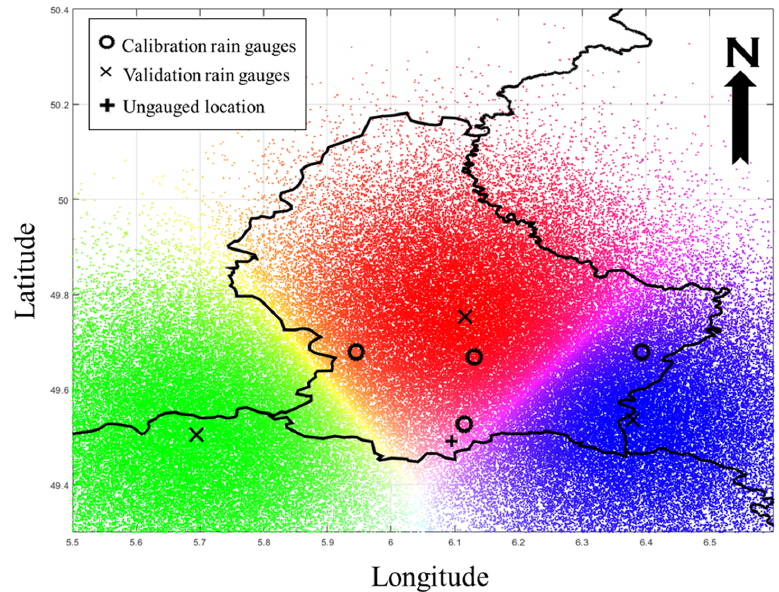
Figure 5. Fuzzy C-means (FCM) clustering on generated data (i-FCM method).